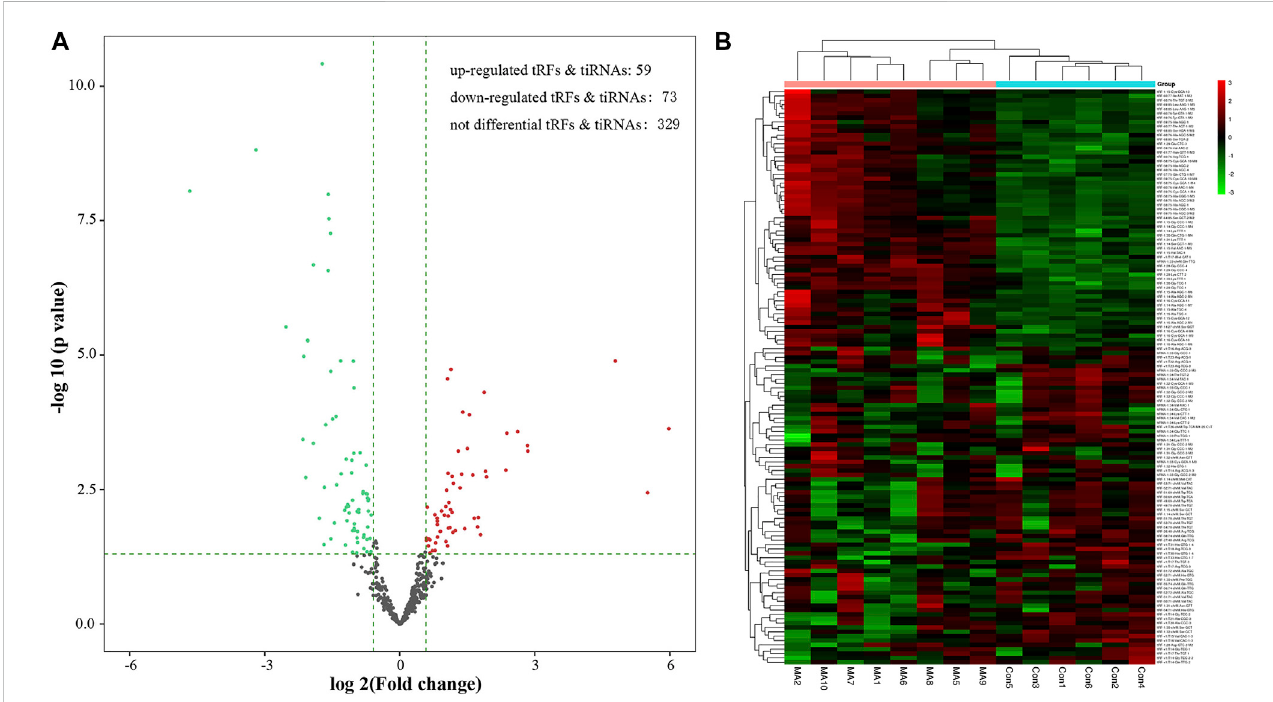
Methamphetamine self-administration alters abundance of tRFs and tiRNAs in the NAc. (A) Volcano plot of tRFs and tiRNAs differentially expressed after methamphetamine self-administration, red and green dots indicate upregulated and downregulated tRFs and tiRNAs in methamphetamine self-